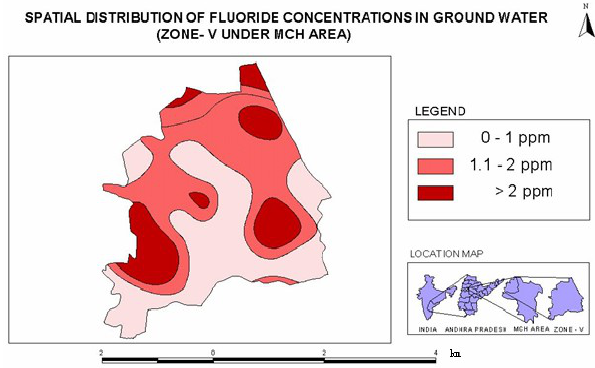
Figure 6 : Spatial Distribution of Fluoride